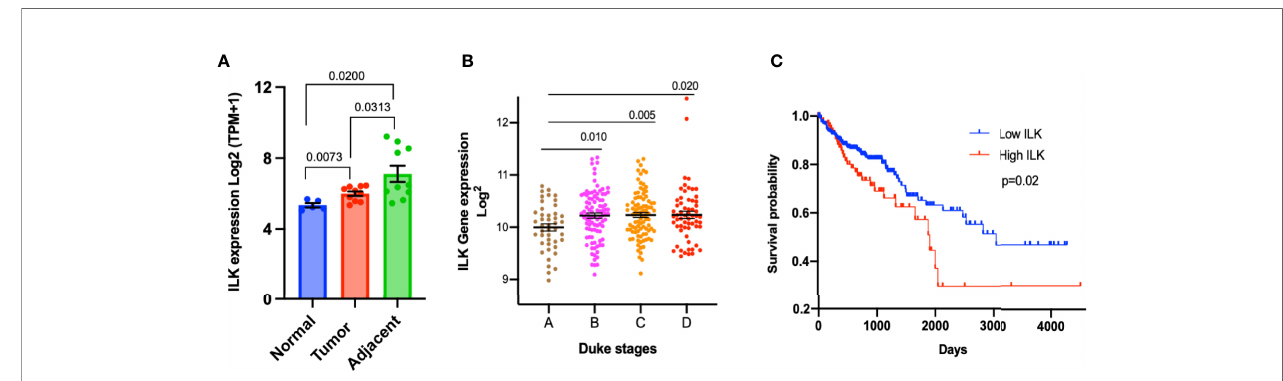
FIGURE 2 | Upregulation of ILK expression in CRC tumors and its correlation with prognosis. (A) The ILK expression levels (Log2(TPM+1)) were examined in a dataset (GSE95132) includes 10 CRC patients (10 CRC tumor tissues (Tumor) and their 10 adjacent non-tumor tissues (Adjacent)) and 5 non-cancer individuals (5 normal colonic crypts (Normal)). The dataset GSE95132 was downloaded from GEO database. (B) ILK expression and its relationship with the Duke ’ s stages of CRC compared by using the GENT2 database. The stages pf CRC (n = 290) are stage A (n = 44); stage B (n = 94); stage C (n = 91); and stage D (n = 61). The fi gure was reproduced from the Gene Expression database of Normal and Tumor tissue (GENT2) at http://gent2.appex.kr/gent2/. (C) Kaplan – Meier curve of overall survival rate between COAD patients showing high and low ILK mRNA expression in the TCGA database through the human protein atlas. The patients were divided into low and high ILK mRNA expression groups, below and above the best cut-off (4.57 FPKM) respectively. Low ILK expression patients (n = 335) and high ILK expression patients (n = 103). The fi gure was reproduced from the human protein atlas at https://www.proteinatlas.org/ENSG00000166333-ILK/ pathology/colorectal+cancer/COAD. Error bars are represented as mean ± SEM. P -value was analyzed with an unpaired t-test. Signi fi cant P -value is <0.05. The signi fi cant P -value is